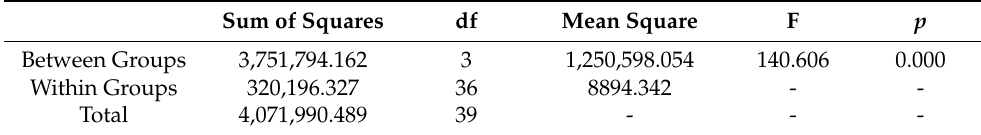
Table 3. One-way ANOVA results of TNT length anodized at 1, 2, 3 and 4 h.